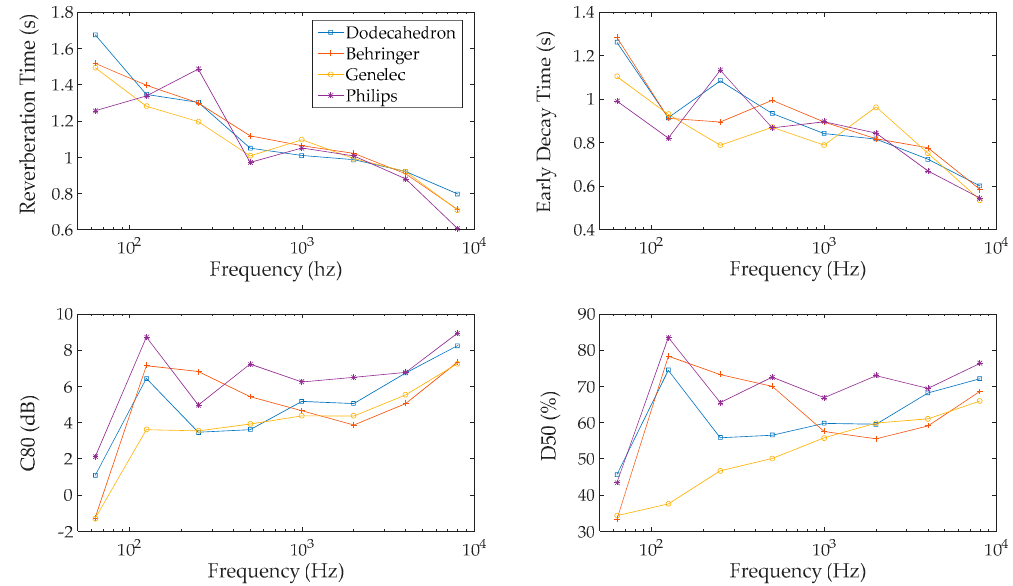
Figure 12. RT, EDT, C 80 and D 50 measured with different speakers.